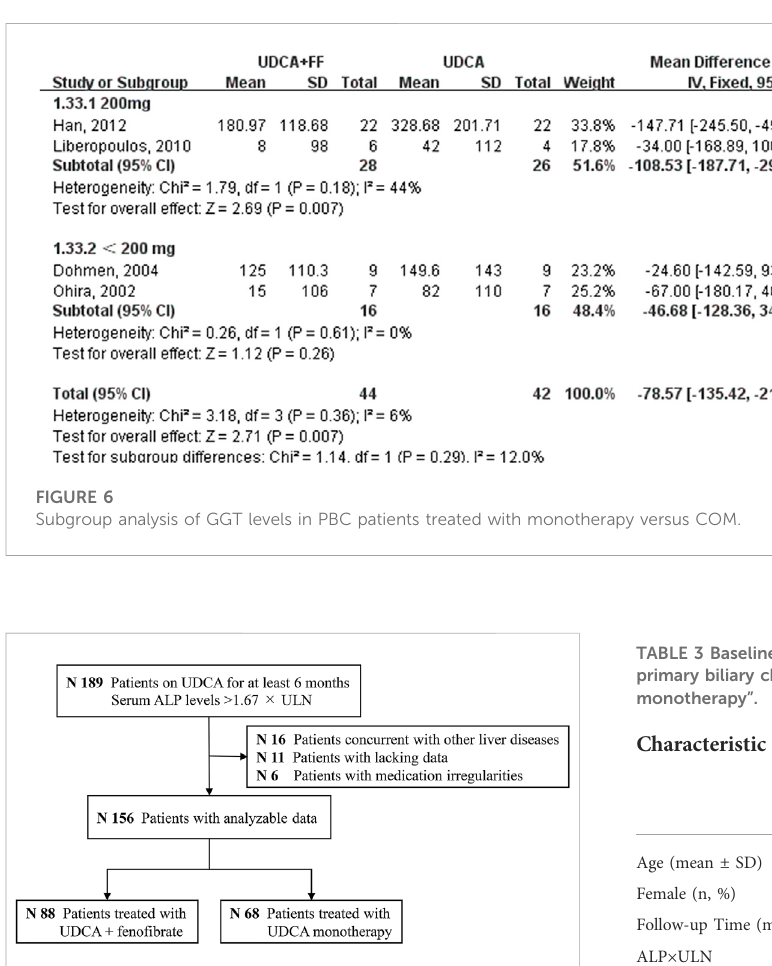
FIGURE 7 Study fl owchart. Abbreviations: ALP, alkaline phosphatase; UDCA, ursodeoxycholic acid; FF, feno fi brate.